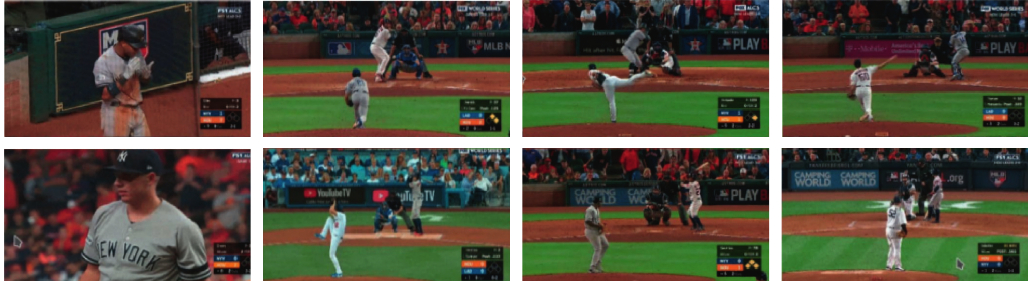
Figure 5: MLB-YouTube classes: no action, foul, hit, and strike. Note that the videos share great similarities with little background